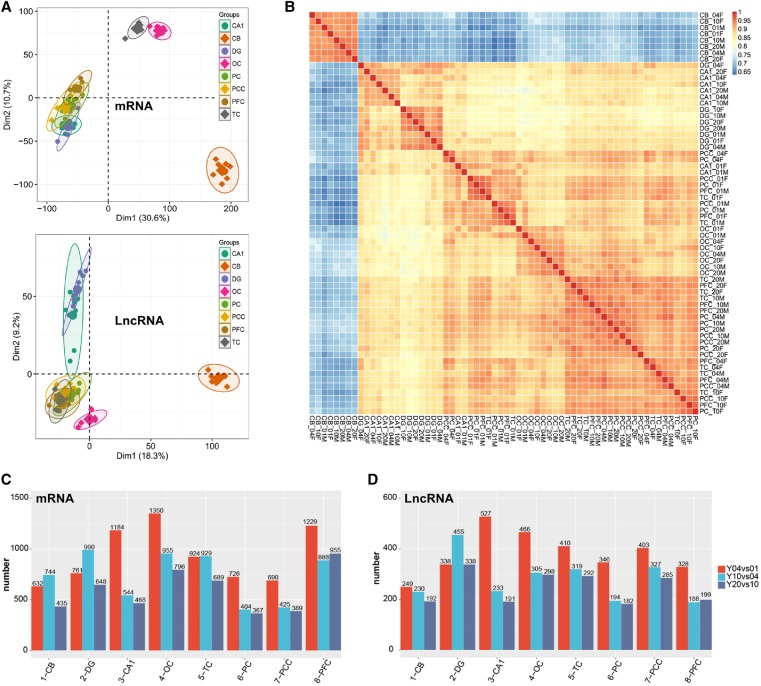
The discrete expression patterns of lncRNAs and mRNAs. (A) Principal component analysis (PCA) of 64-pair distinct samples across the four ages based on normalized mRNAs (top) and lncRNAs (bottom) expression level. The samples were grouped by brain region, and the ellipse for each group is the confidence ellipse. (B) Heat map of correlation coefficient for 64 samples based on the lncRNA expression level. The samples were grouped by hierarchical clustering, and the dendrogram was not shown. (C,D) Bar plot presentation of differentially expressed mRNAs (C) and lncRNAs (D) based on neighboring age groups.